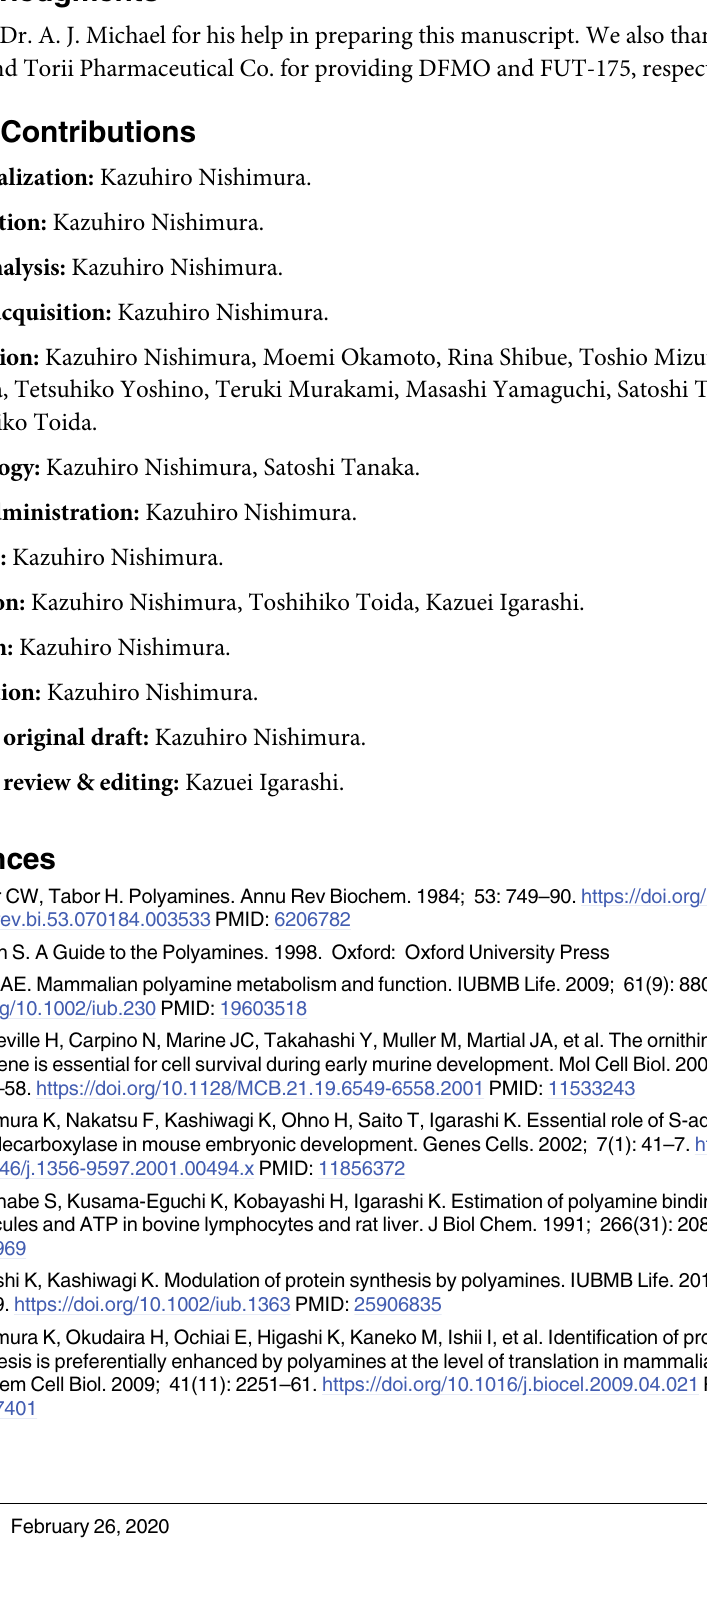
S4 Fig. Cell number and intracellular amines in BMMCs in the absence or presence of DFMO and